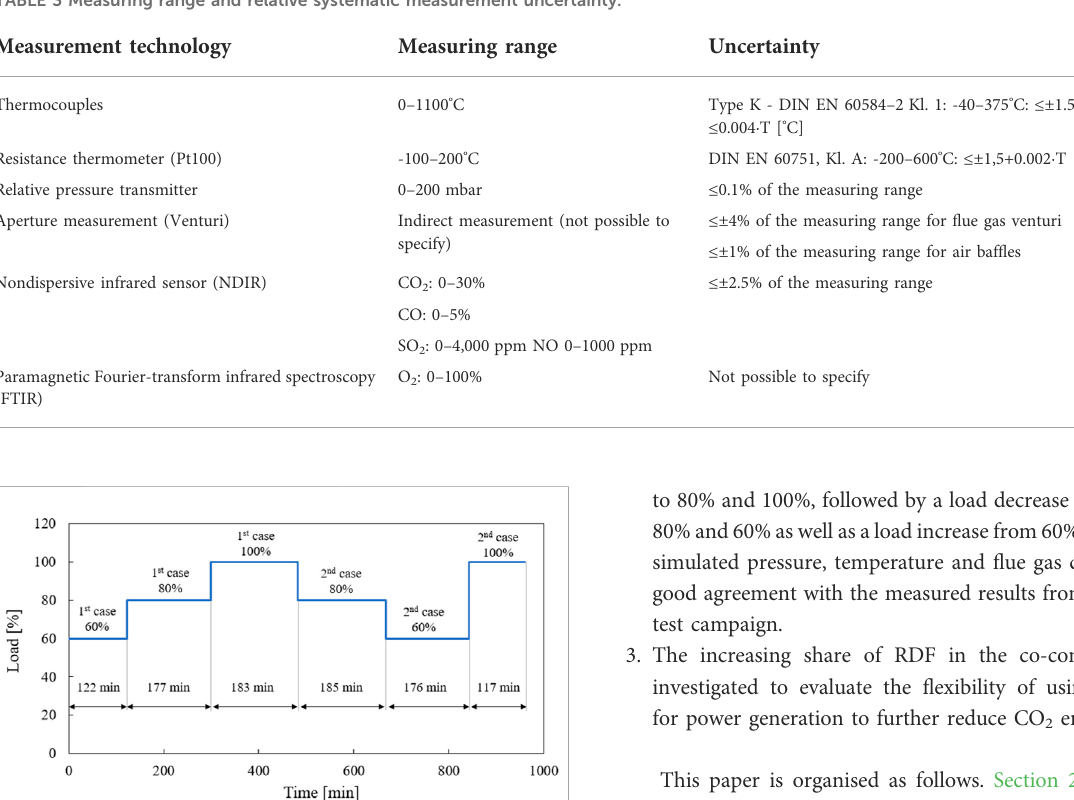
TABLE 3 Measuring range and relative systematic measurement uncertainty.